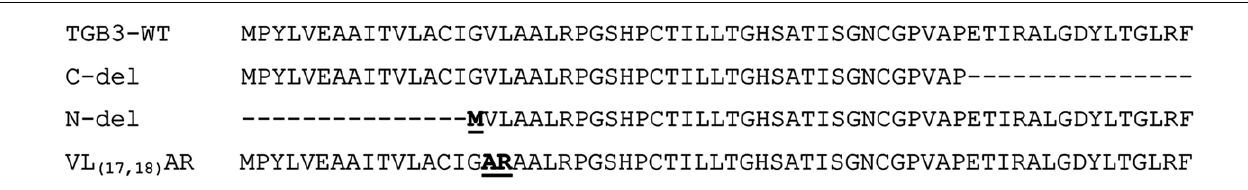
FIGURE 2 |Amino acid sequence of mutants ofAltMVTGB3 used for BiFC reactions. Altered residues are shown in bold and underlined.